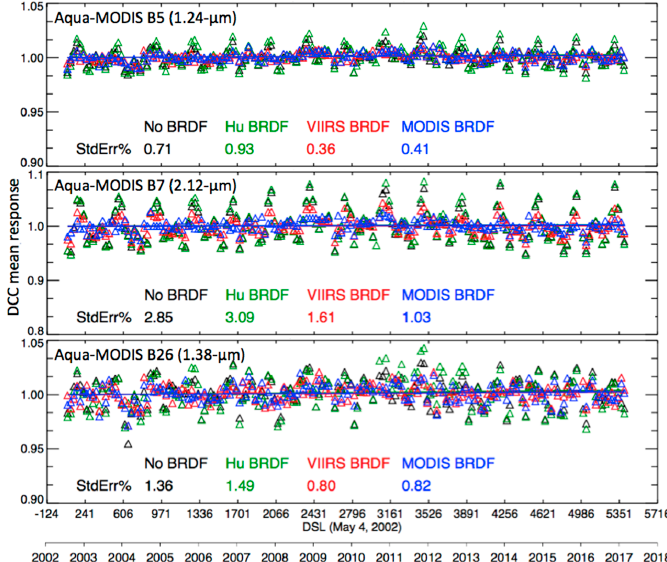
Figure 10. The normalized DCC Mean reflectance time series for Aqua-MODIS SWIR bands when using no BRDF, Hu BRDF, monthly VIIRS BRDF, and monthly MODIS BRDF.